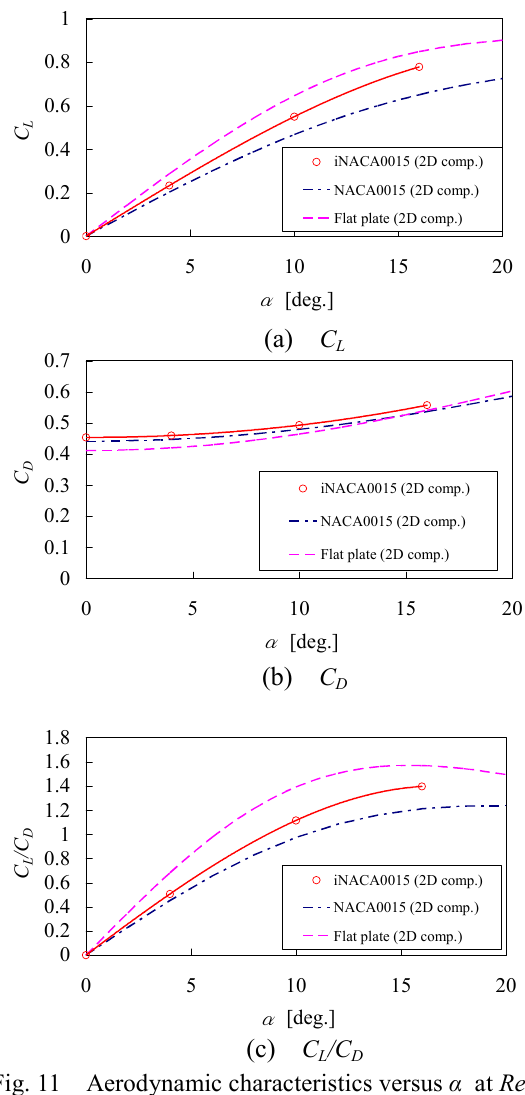
Fig. 11 Aerodynamic characteristics versus α at Re =1.0×10 2